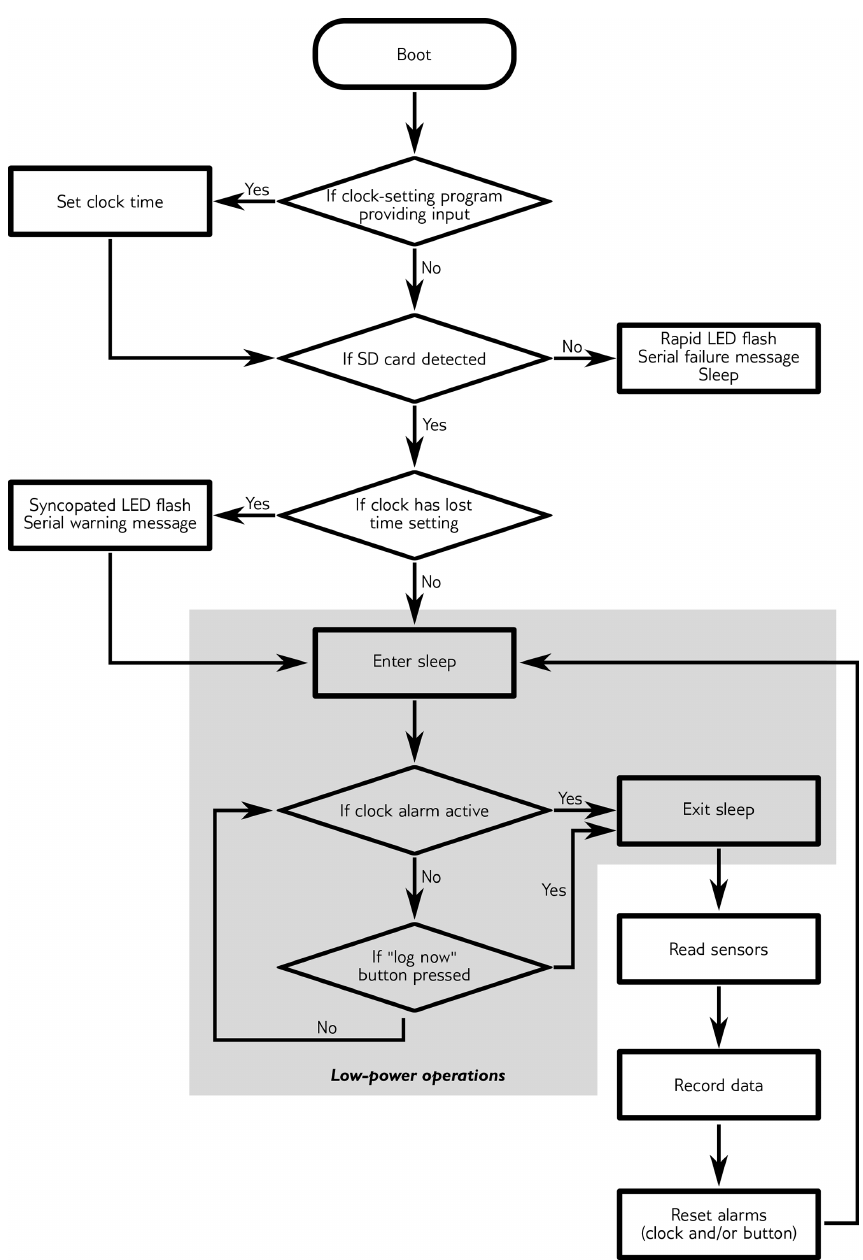
Figure 3. Flowchart of ALog operations. This set of steps is prescribed by the firmware. Not pictured is the watchdog timer, which resets the data logger, returning it to the “boot” step, if it hangs for more than